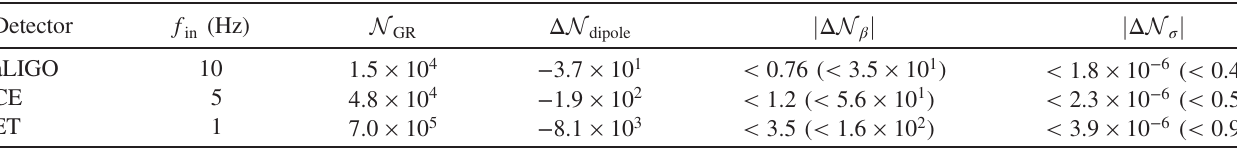
, for a BNS merger with masses ð 1 . 25 M ⊙ ; 1 . 7 M ⊙ Þ for frequencies f > f , and GR in − α ≃ 0 . 0199 , which comes from the , assuming j Δ α j ≡ j α A B j dipole